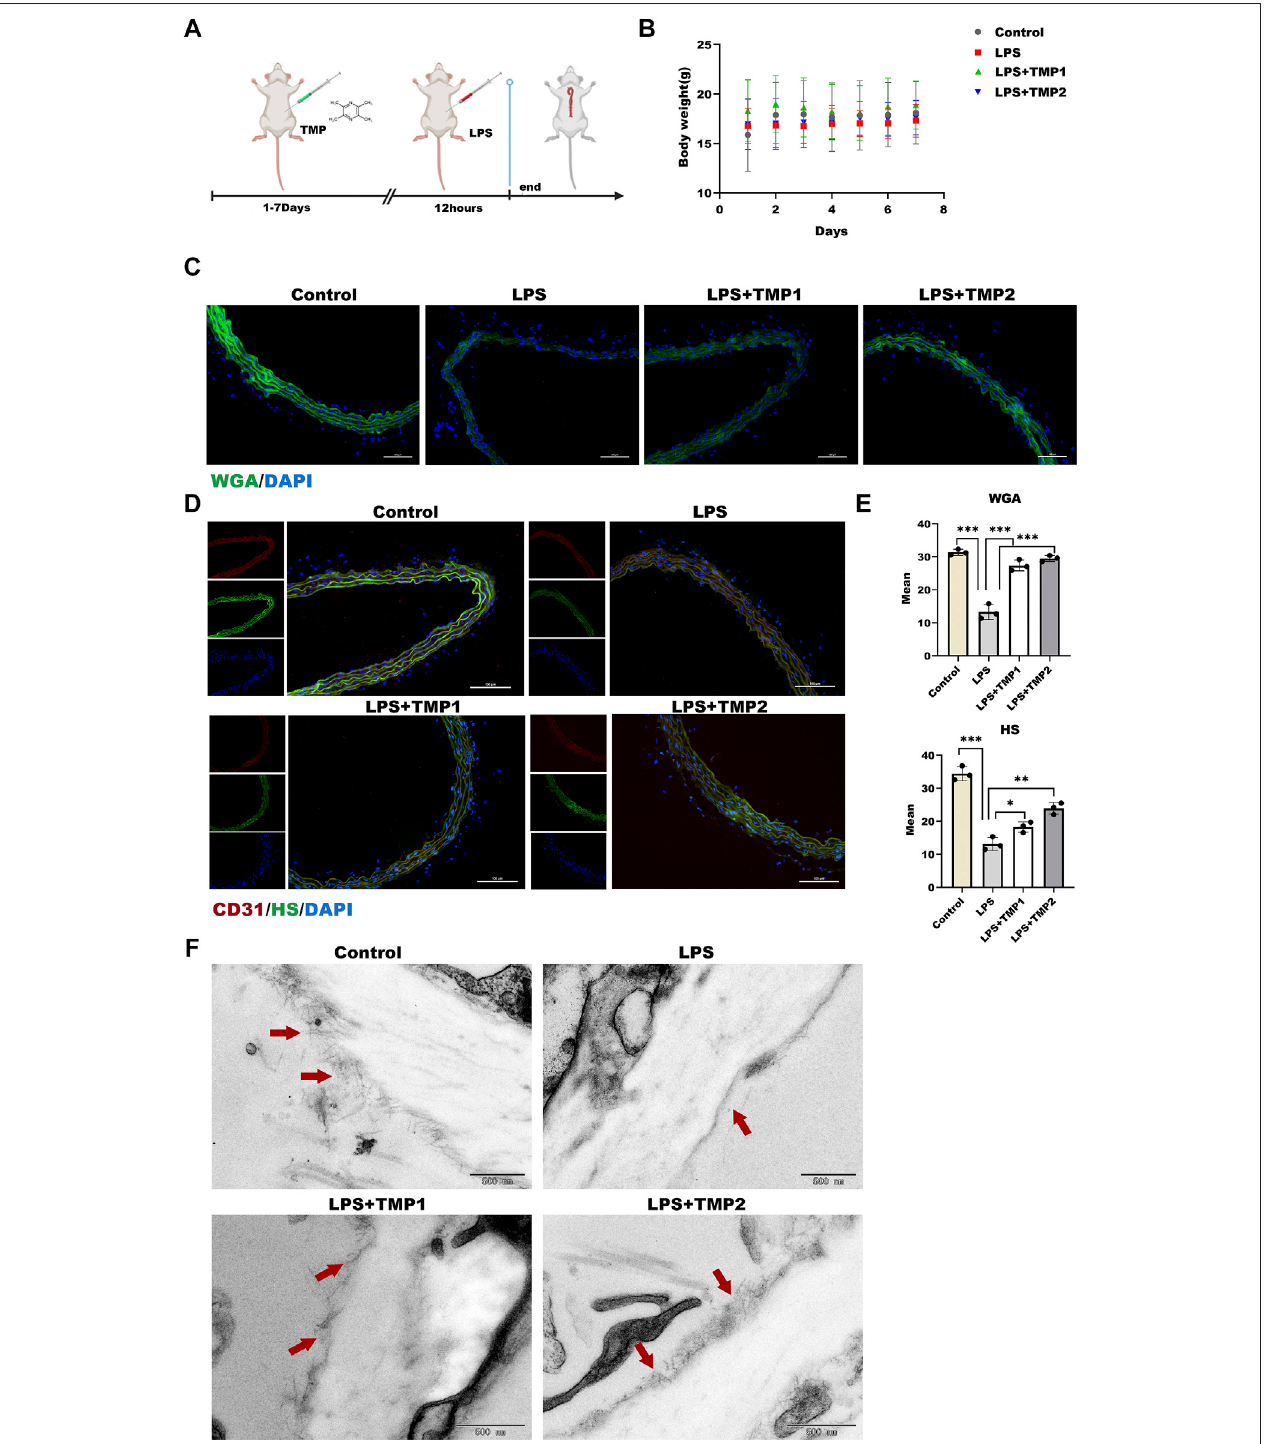
FIGURE 6 | Effect of TMP on endothelial glycocalyx integrity in vivo (A) After intraperitoneal injection of TMP (3 mg/kg, 6 mg/kg) for 7 days, the mice were injected intraperitoneallywithLPS(2.5 mg/kg)for12 h.Themiceweresacri fi ce,serumandaortawerecollected (B) Dailybodyweightrecordingofmiceduringfeedingperiod (C) SectionsoftheaortawerestainedwithWGALectinFITC(Green),DAPI(Blue)byimmuno fl uorescenceandMean fl uorescencequantitativestatistic( n (cid:2) 3) (D) HS(Green) expression in the aorta was expressed by immuno fl uorescence. CD31 (Red), DAPI (Blue) (E) Fluorescence of (D) and (E) was quanti fi ed by ImageJ (F) The glycocalyx of the aorta was photographed by transmission electron microscopy, The red arrow points to a villous glycocalyx. * p < 0.05. ** p < 0.005; *** p < 0.001.